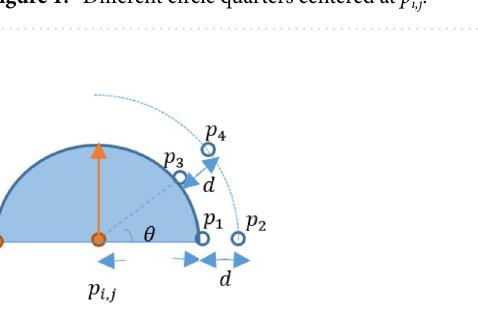
Figure 1. Different circle quarters centered at p i,j .